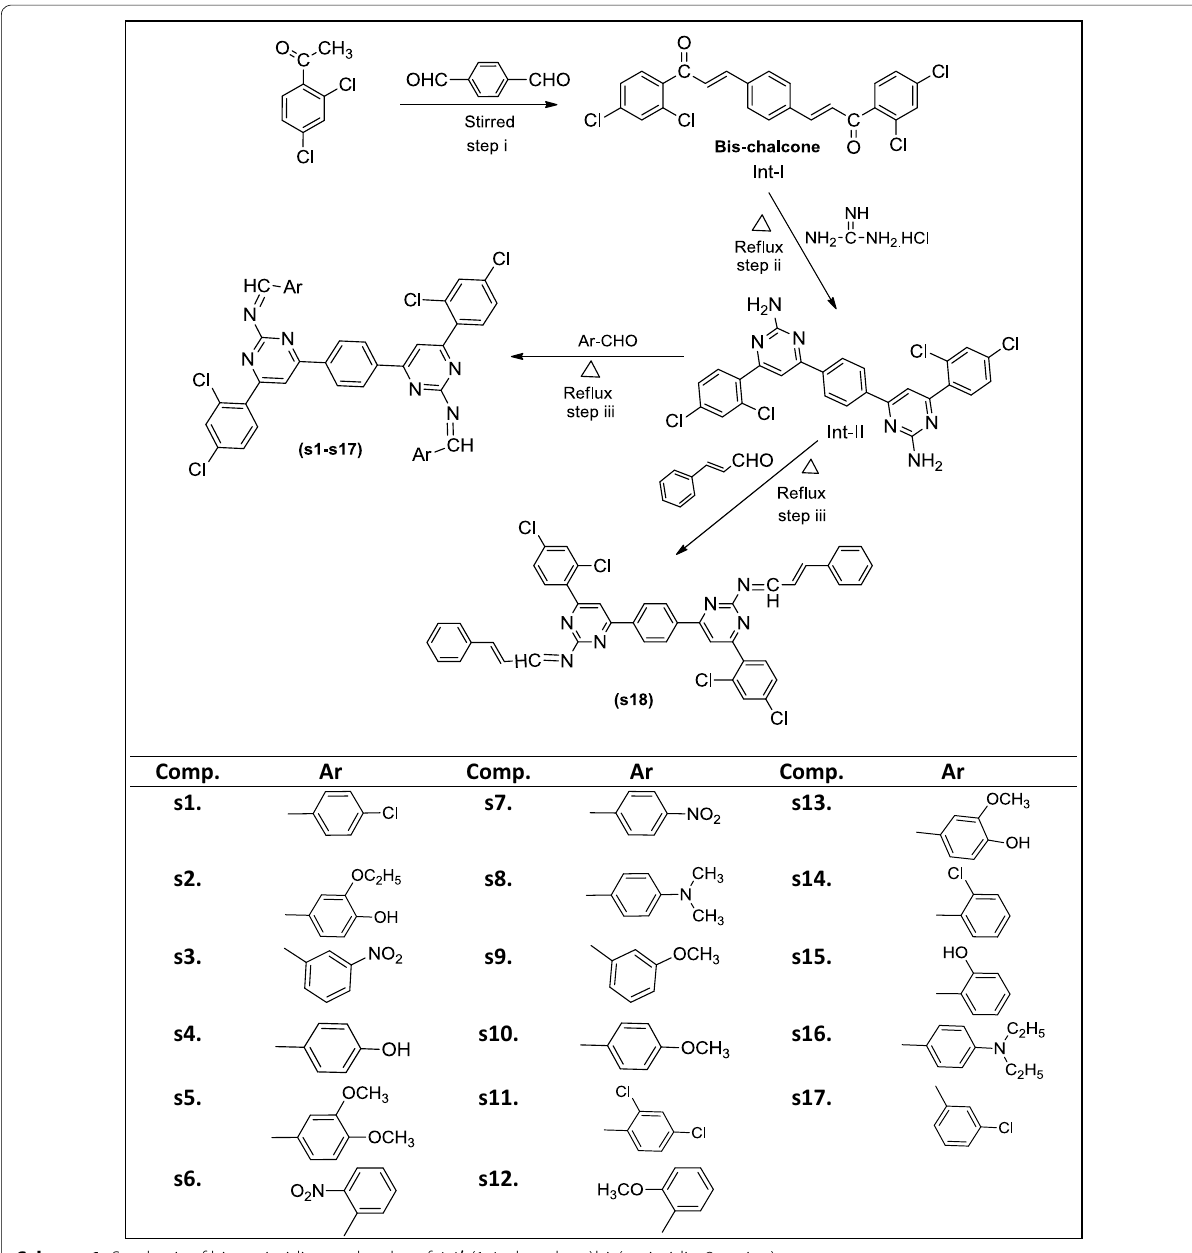
(IR) was recorded (KBr-pellets) in Bruker 12060280, Software: OPUS 7.2.139.1294 spectrometer. 1 H-NMR and 13 C-NMR were recorded at 600 and 150 MHz respectively on Bruker Avance III 600 NMR spectrom- eter by appropriate deuterated solvents. The results are conveyed in parts per million ( δ , ppm) downfield from